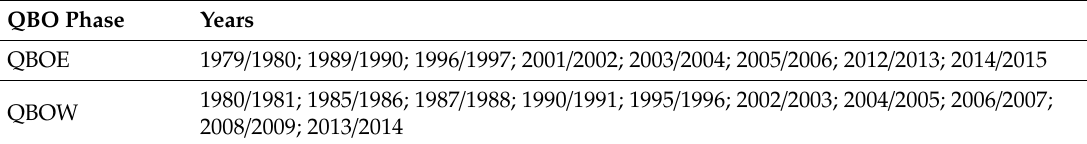
Table 1. The QBO easterly (QBOE) and QBO westerly (QBOW) years in neutral El Niño-Southern Oscillation (ENSO)